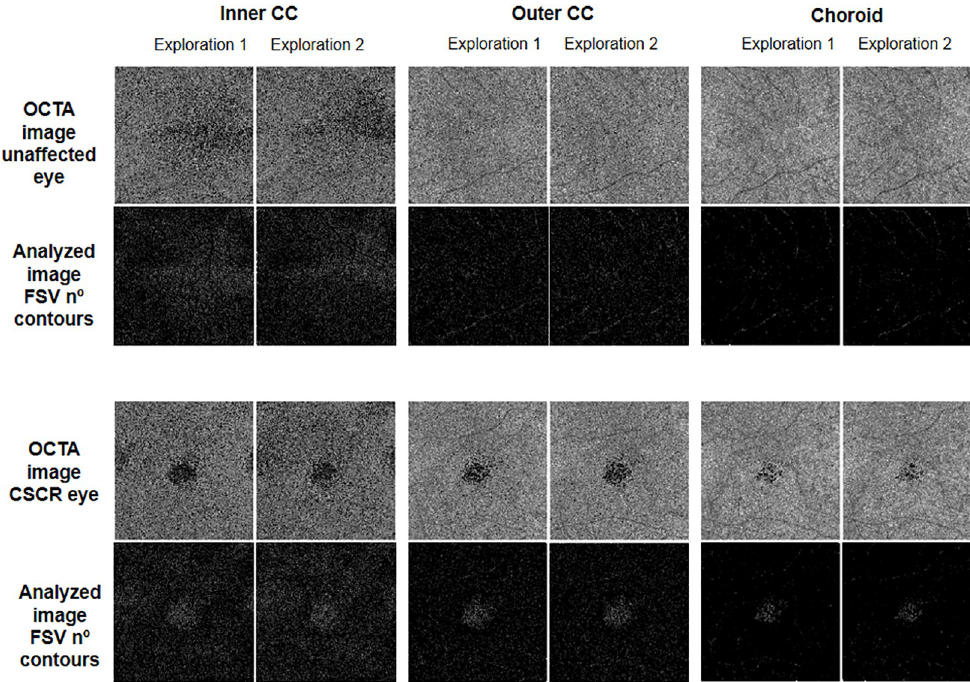
Fig 3. Optical coherence tomography angiography (OCTA) images and the corresponding analyzed images of the flow signal voids (FSV) number of contours of the three slabs studied (inner choriocapillaris, CC; outer CC and choroid) for the explorations 1 and 2 in central serous chorioretinopathy (CSCR) and fellow